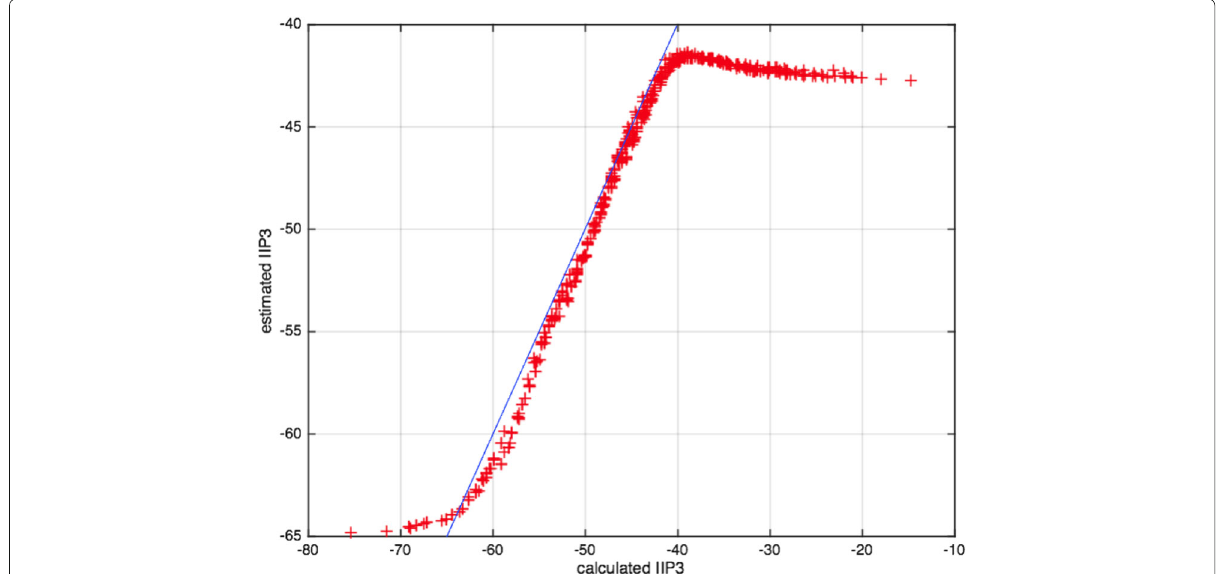
Fig. 3 Calculated IIP 3 from library data is given on the x -axis and estimated IIP 3 from simulation is given on the y -axis when three amplifiers are reconfigured in a reconfigurable RF front-end. There are two saturation areas according to where the IIP 3 estimate is: the lower boundary around − 65 dBm and the upper boundary around − 42 dBm IIP